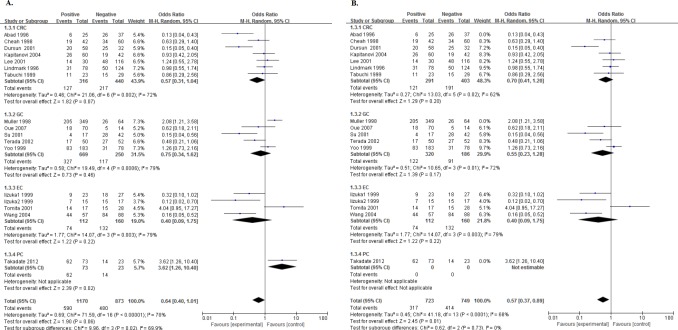
Forest plot of odds ratio (OR) for the association between NME1 overexpression and overall survival (OS) in patients with different tumor types with random effects model.A. The ORs for OS; B. The new ORs for OS.